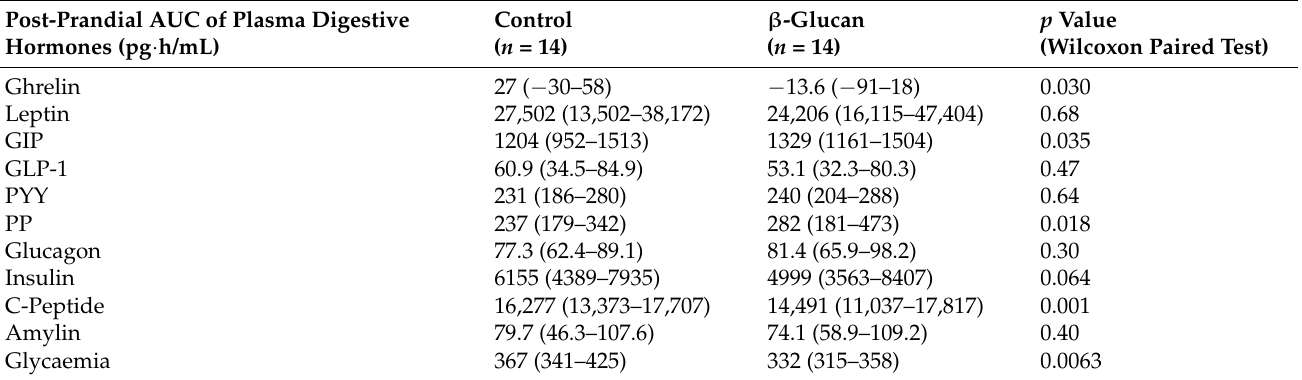
Table 3. The area under the curves (AUC) of post-prandial plasma concentrations of digestive hormones and glucose during the control and β -Glucan periods (Means (CI 95%